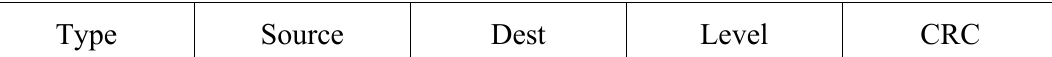
Figure 2. Format of a broadcast-route packet.